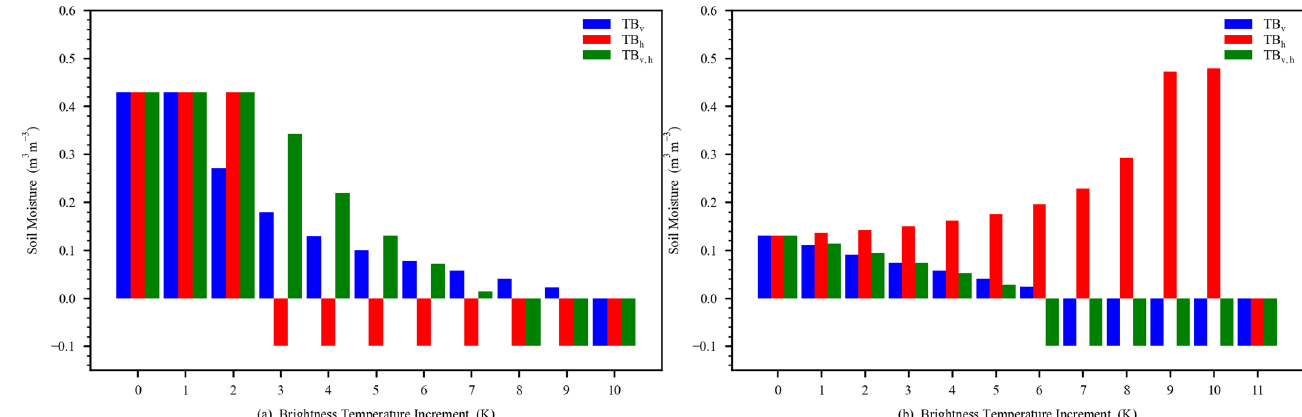
Figure 4. The trend of the retrieved soil moisture with increasing brightness temperature for wet point ( a ) and dry point ( b ). Blue, red, and green indicate vertical brightness temperature, horizontal brightness temperature, and both simultaneously, respectively. Negative numbers indicate that the retrieved process does not converge.